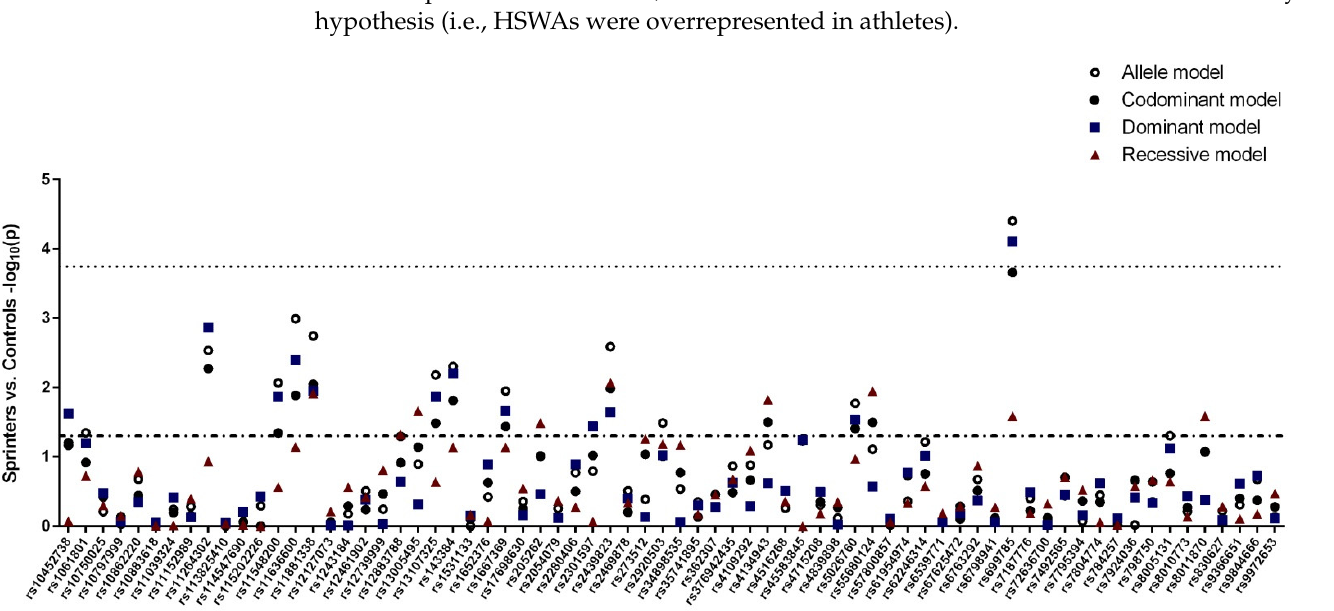
Figure 2. Genetic association tests of single-nucleotide polymorphisms (SNPs) related to self-reported walking pace between elite sprinters and ethnically matched controls. The y -axis represents the negative log10-transformed p -values of each of the evaluated genetic models, and the x -axis indicates the SNPs, according to the reference SNP ID numbers (rs nos.). The dashed line represents the significance threshold for nominal associations ( p < 0.05), and the dotted line represents the significance threshold adjusted for multiple comparisons ( p < 0.00018).